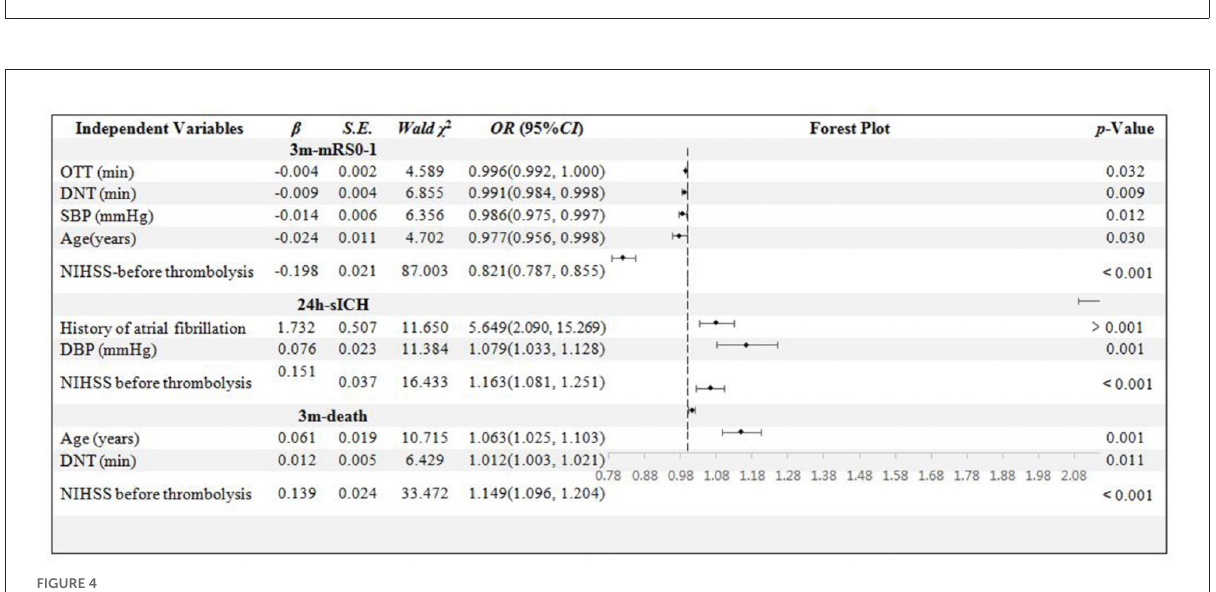
FIGURE3 Binary logistic regression analysis in age ≥ 80 years group. NIHSS, National Institute of Health stroke scale; mRS, modified Rankin scale; sICH, symptomatic intracranial hemorrhage.